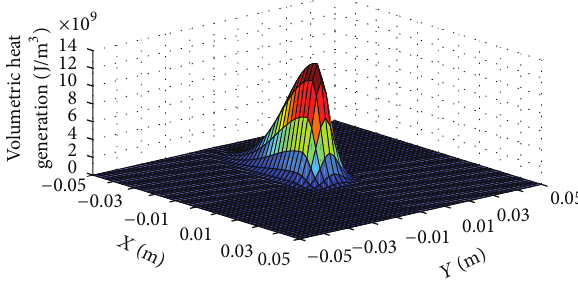
Figure 1: Double ellipsoidal heat